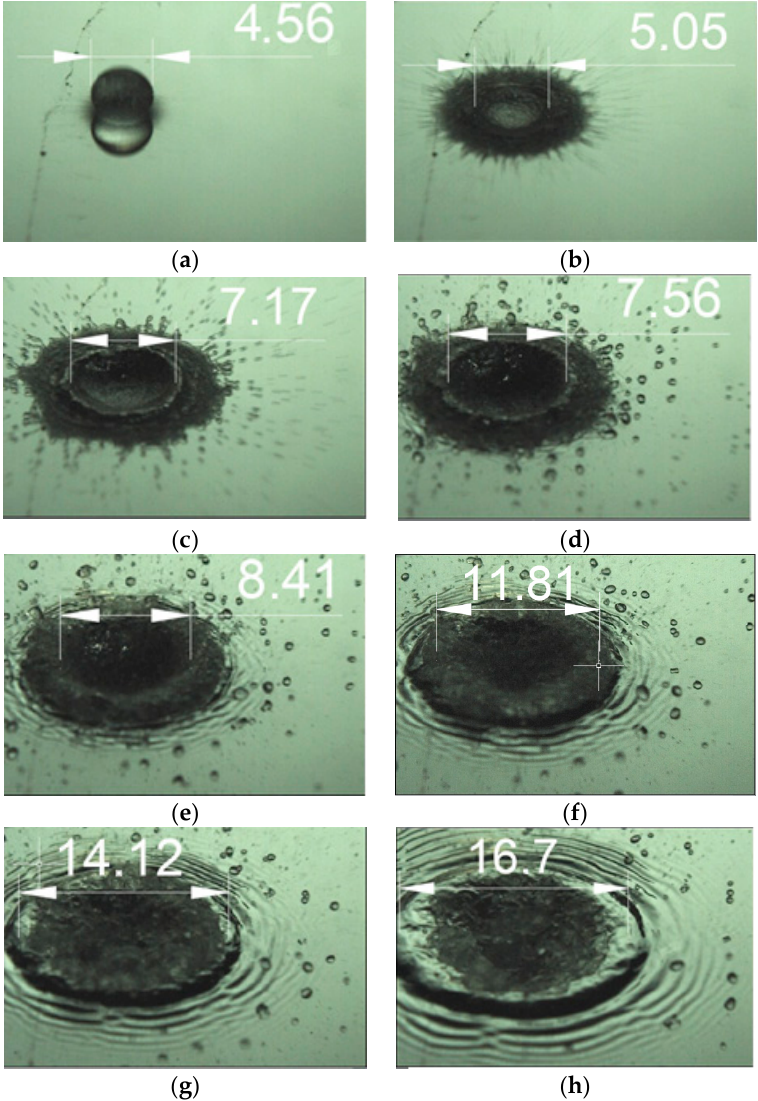
Figure 3. Snapshots of Case 1 video at the instances indicated in Figure 2 (the dimensions are in millimeters). ( a ) t = 0 ms; ( b ) t = 1 ms; ( c ) t = 2.8 ms; ( d ) t = 6.2 ms; ( e ) t = 10 ms; ( f ) t = 13.2 ms; ( g ) t = 15.4 ms; ( h ) t = 20 ms.